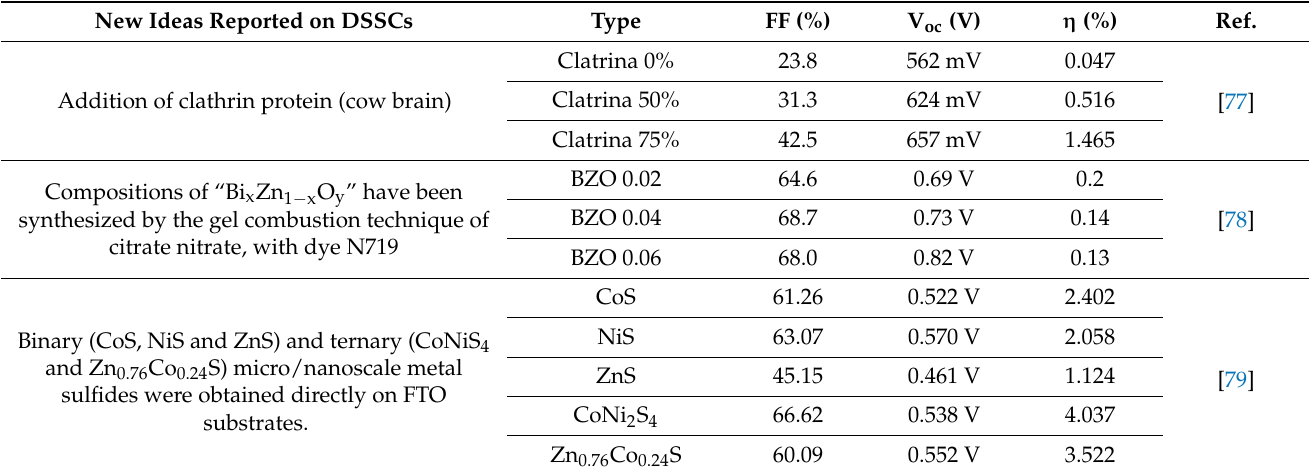
Table 9. Recent papers that claim novel ideas on